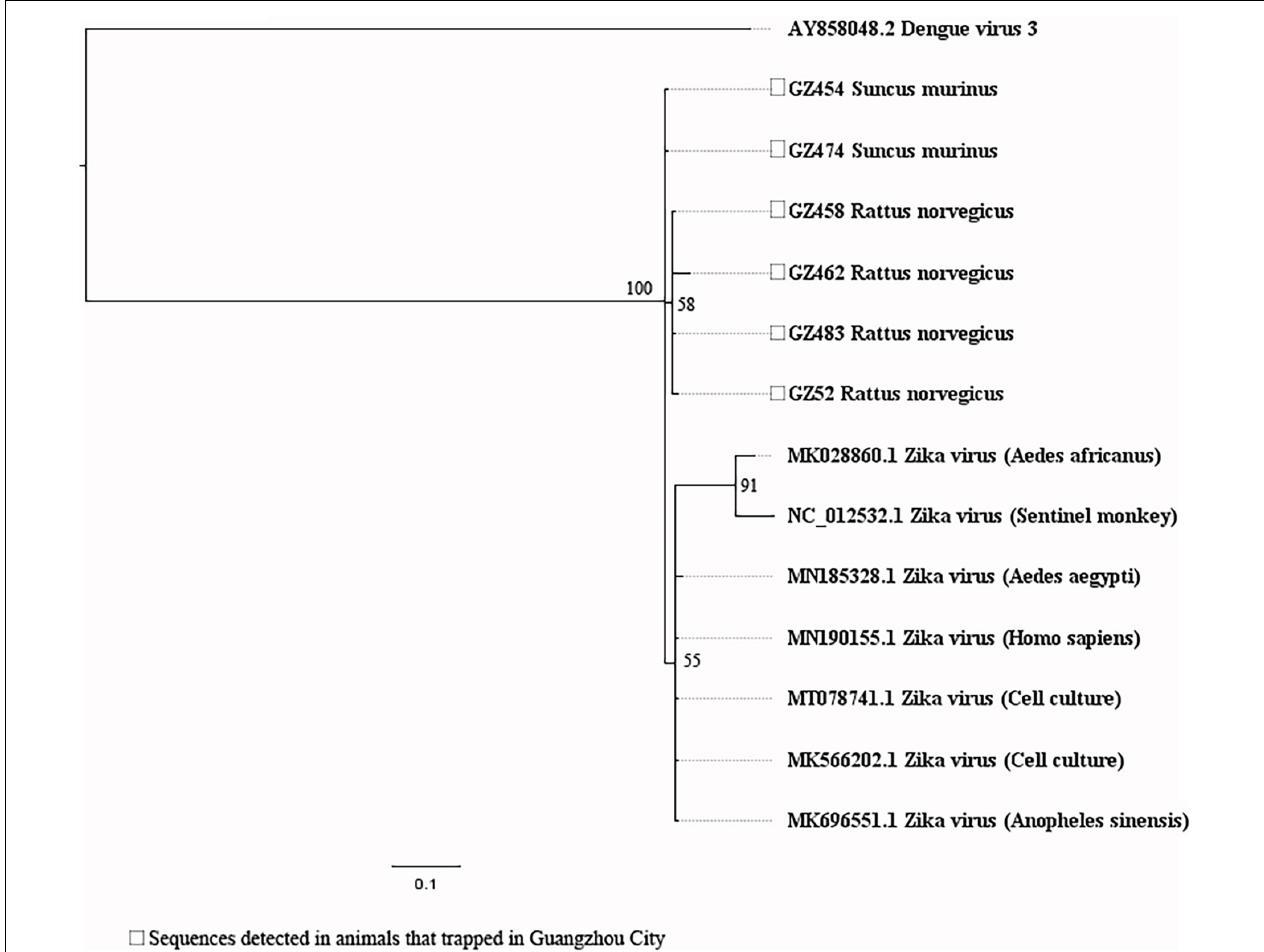
FIGURE 6 | Phylogenetic tree constructed based on PCR-screened nucleotide sequences (156 bp) of Zika virus (ZIKV) from urban rats and house shrews (MrBayes, GTR + G + I nucleotide substitution model). A total of seven representative sequences of ZIKV derived from human, Aedes aegypti , and Anopheles sinensis are included for comparison (polyprotein gene region). One dengue virus sequence is set as outgroup (polyprotein gene region). Percentages of the posterior probability (PP) values are indicated.